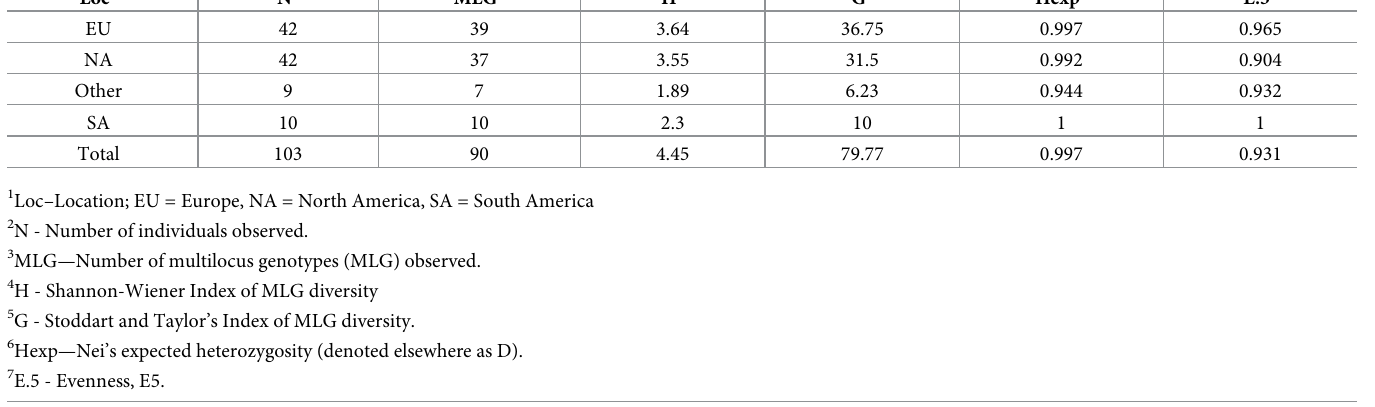
Fig 3. Maximum parsimony tree of 6.175 kb concatenated alignment of the mitochondrial sequences from five loci used in classification of haplotypes with the bootstrap values at the nodes reflective of values obtained in maximum parsimony (top), maximum likelihood (middle) and Bayesian analysis (posterior possibilities; bottom). Partition homogeneity test results for the combined dataset was 0.06.